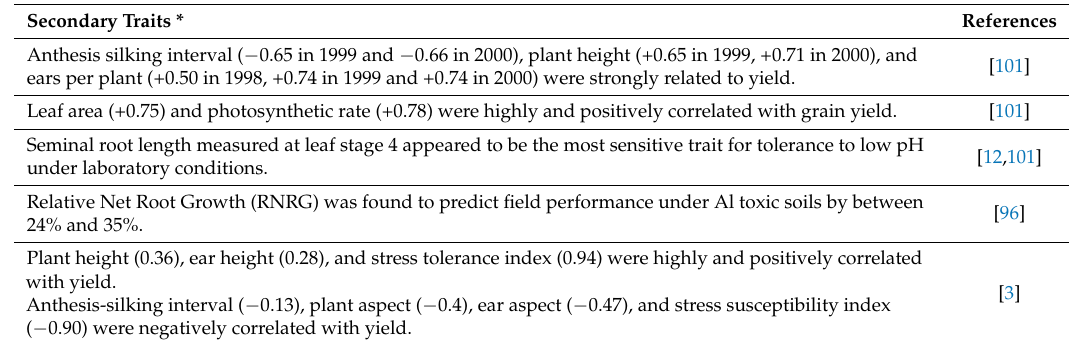
Table 2. Secondary traits associated with tolerance to low soil